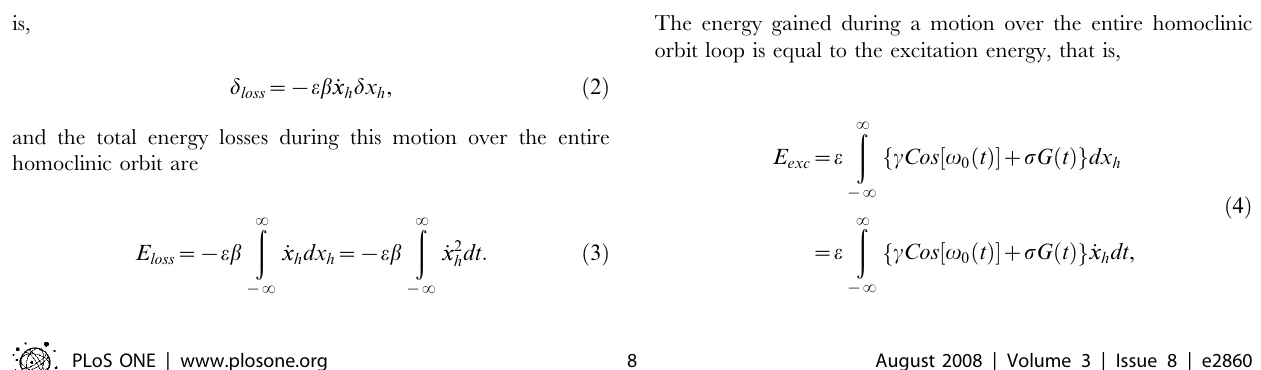
Figure 5. Theoretical model for crossmodal SR. (Top) Potential V(x); (middle) Phase plane diagram showing homoclinic orbits; (bottom) Melnikov scale factor for a 2 =1.